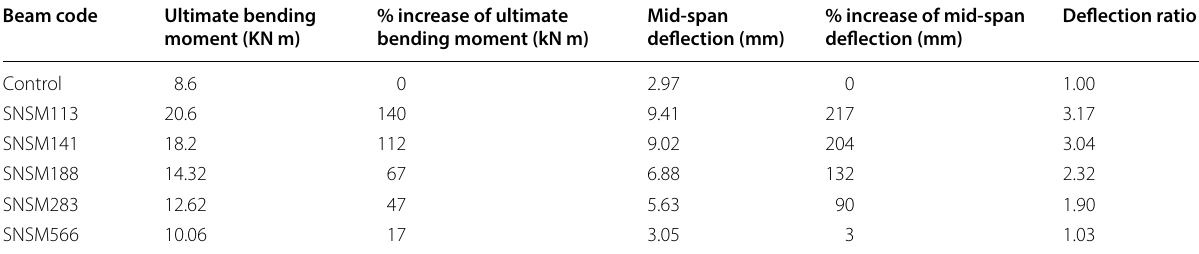
Table 5 Bending moment and mid-span deflection.